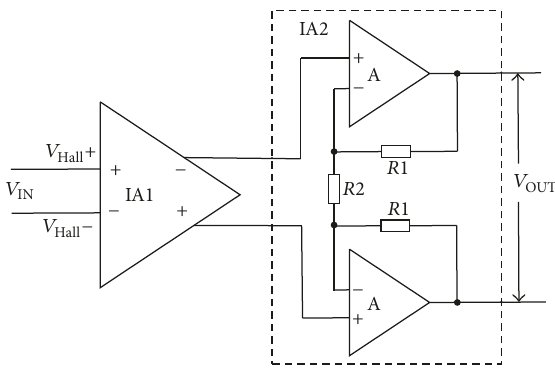
Figure 8: Amplifying circuit module of the Hall switch sensor.